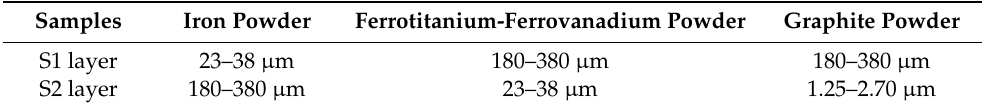
Table 1. Particle size of the cladding alloy